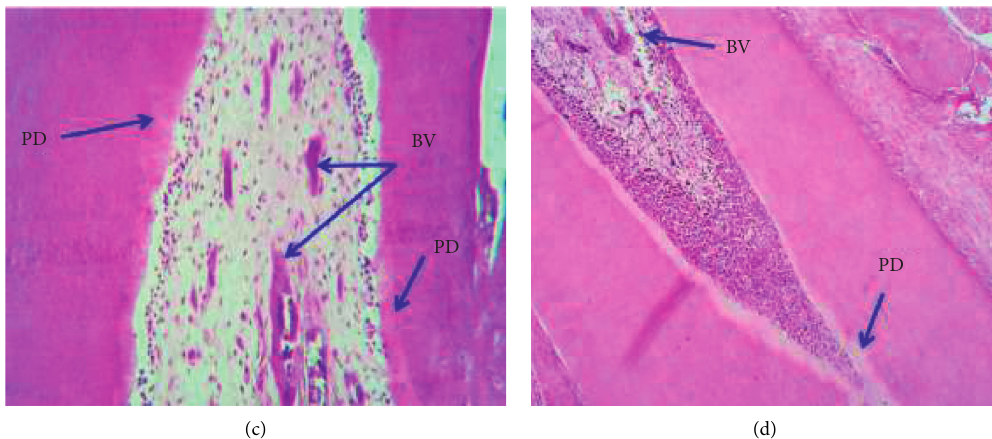
Figure 3: Representative histological images under the light microscope (H&E, × 10) showing (a) dental pulp at the control group with very thin layers of the predentin and a high number of blood vessels, (b) 25mg/kg CaO-NP treatment with a slightly thicker predentin and a low number of blood vessels, (c) 50mg/kg CaO-NP treatment with a slightly thicker predentin and a low number of blood vessels, and (d) 100mg/kg CaO-NP treatment with a thick and irregular predentin (PD) and very low number of blood vessels (BV).